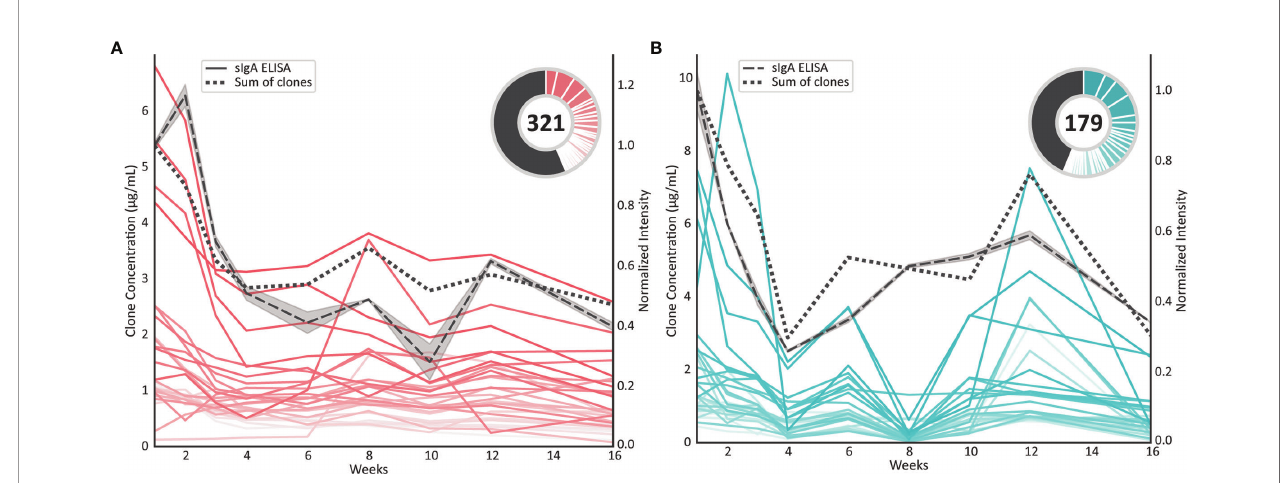
FIGURE 5 | Concentration pro fi les of individual sIgA1 clones compared to the total sIgA concentration pro fi le. (A) Longitudinal individual sIgA1 concentration pro fi les observed for donor 1. Each pink line represents a unique sIgA1 clone. The dotted black line represents the summed concentrations over all detected sIgA1 clones, whereas the dashed black line represents the total sIgA concentration as evaluated by an independent sandwich ELISA. The relative abundance of the top 30 clones at week 1 are shown in the pie charts, where the number in the center indicates the total number of clones that could be monitored longitudinally. For these analyses clones were included when present in at least 7 of the 9 time points. The top 30 clones each have a slice in the pie chart and the remainder of the clones are depicted as black pie slice. (B) As in A) individual sIgA1 concentration pro fi les observed for donor 2. Each blue line represents a unique sIgA1